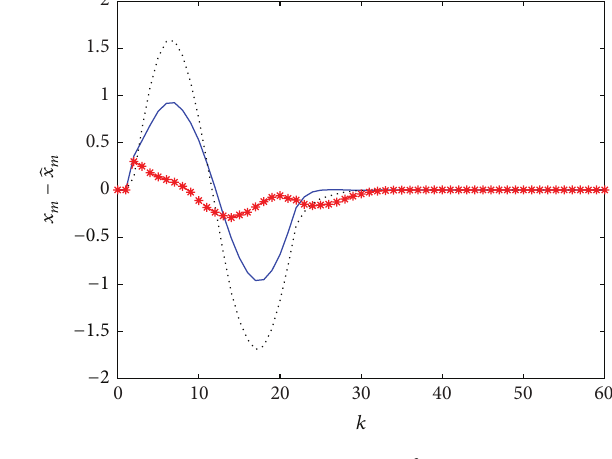
Figure 3: Estimation error of mRNAs.